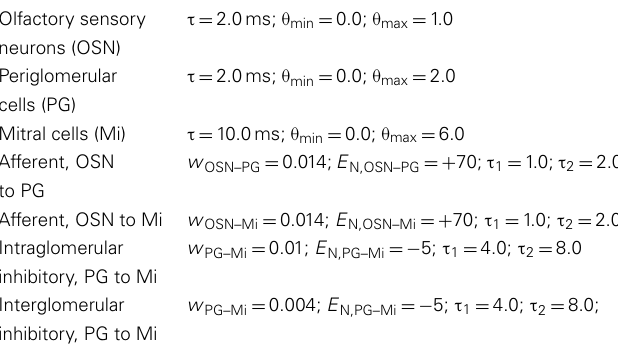
Table 1 | Computational model